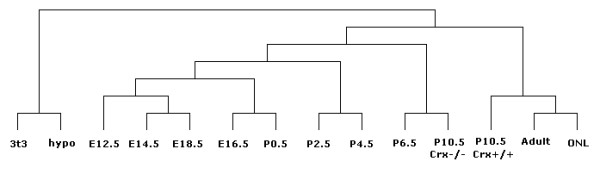
A hierarchical tree for 14 SAGE libraries based on analysis of 261 PR-enriched tags. This hierarchical tree provides further insights. The split at birth is less marked. The P10.5 Crx-/- library is clustered with the P6.5 library rather than with its wild type counterpart.